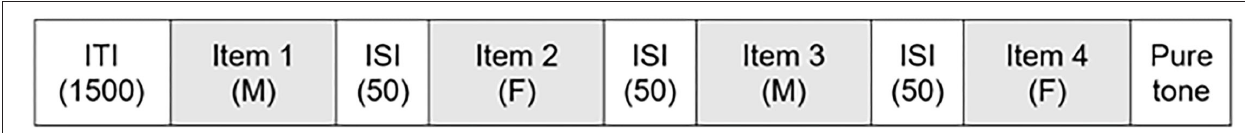
FIGURE 1 | Structure of the experiment.